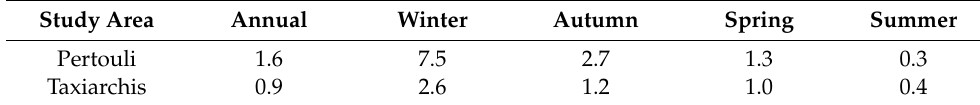
Table 1. Analysis of the P/PET ratio for the selected forest ecosystems. Study